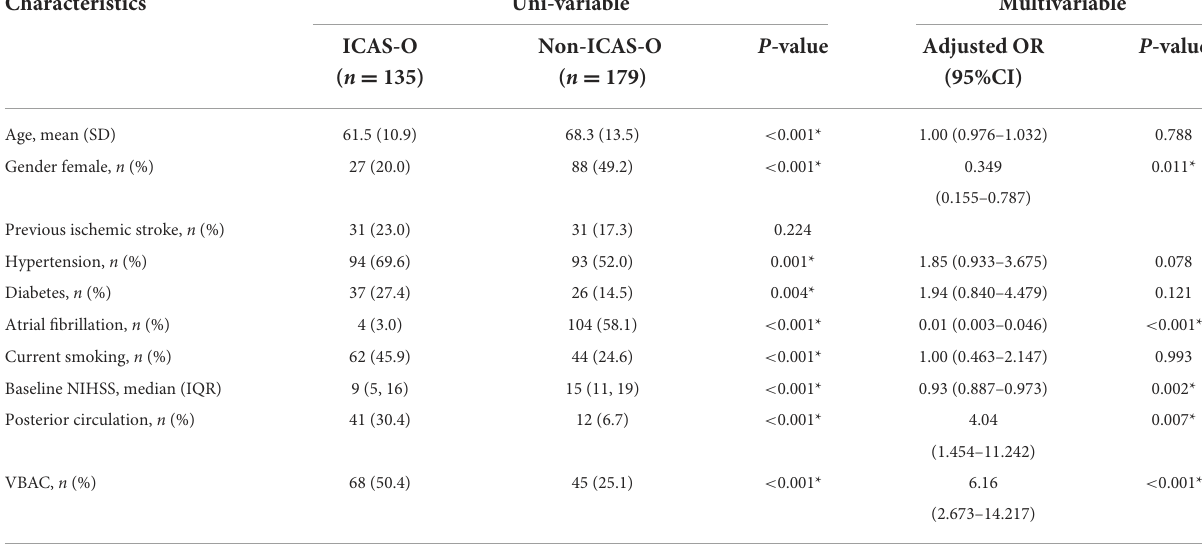
TABLE 2 Univariable and multivariable logistic analyses of possible predictors for ICAS-O. Characteristics